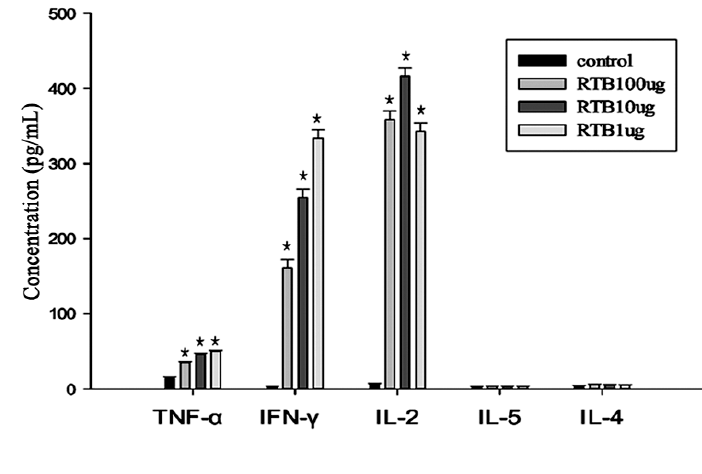
Figure 6. Expression of TNF- α , IFN- γ , IL-2, IL-4 and IL-5 in spleen cells from mice with different concentration of RTB through cytometric bead array immunoassay (CBA) analysis. Splenocytes were stimulated with RTB (1, 10 and 100 μ g/mL) in the presence of 2.5 μ g/mL ConA for 48 h. The culture supernatants were collected and assessed for cytokine production (TNF- α , IFN- γ , IL-2, IL-5, IL-4) by CBA analysis. Data are